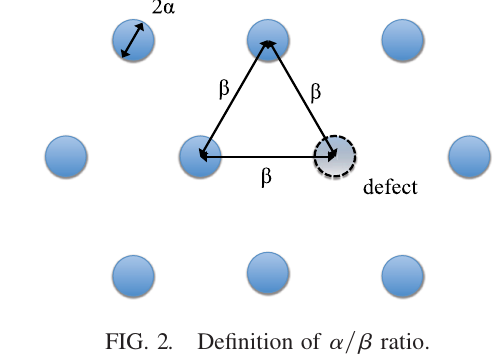
FIG. 2. Definition of (cid:1)=(cid:2) ratio.